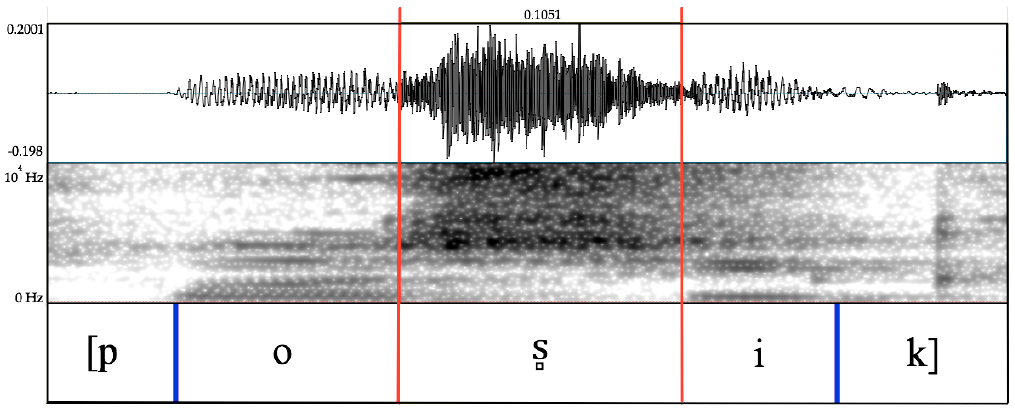
Figure 1. Waveform and spectrogram of the sibilant in the word pozik ‘happy’.